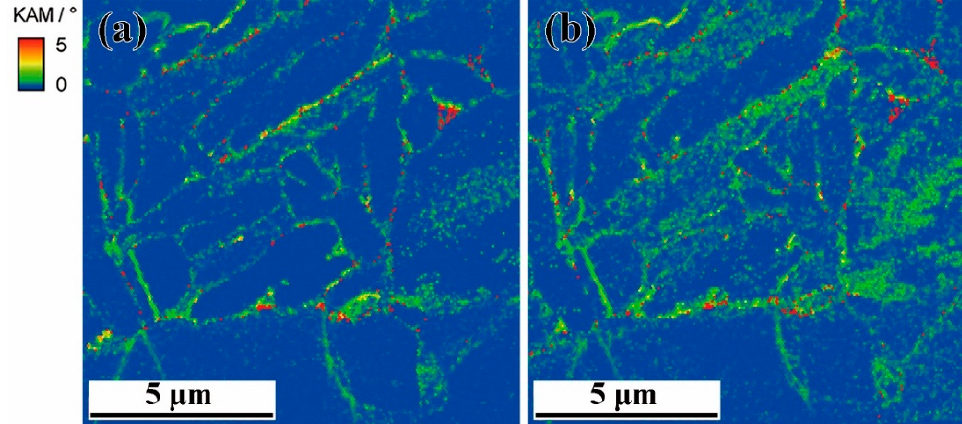
Figure 5. The Kernel Average Misorientation (KAM) maps of the Ti-6Al-4V specimen ( a ) before and ( b ) after magnetic exposure.